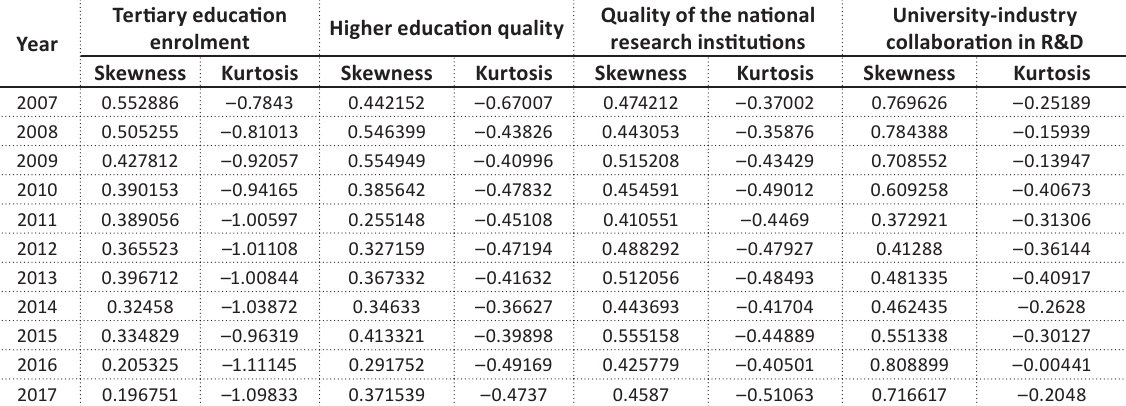
Table 3. Higher education systems’ Pearson coefficients of skewness and kurtosis (values) (152 countries, 4 indicators characterizing the national higher education systems), 2007–2017